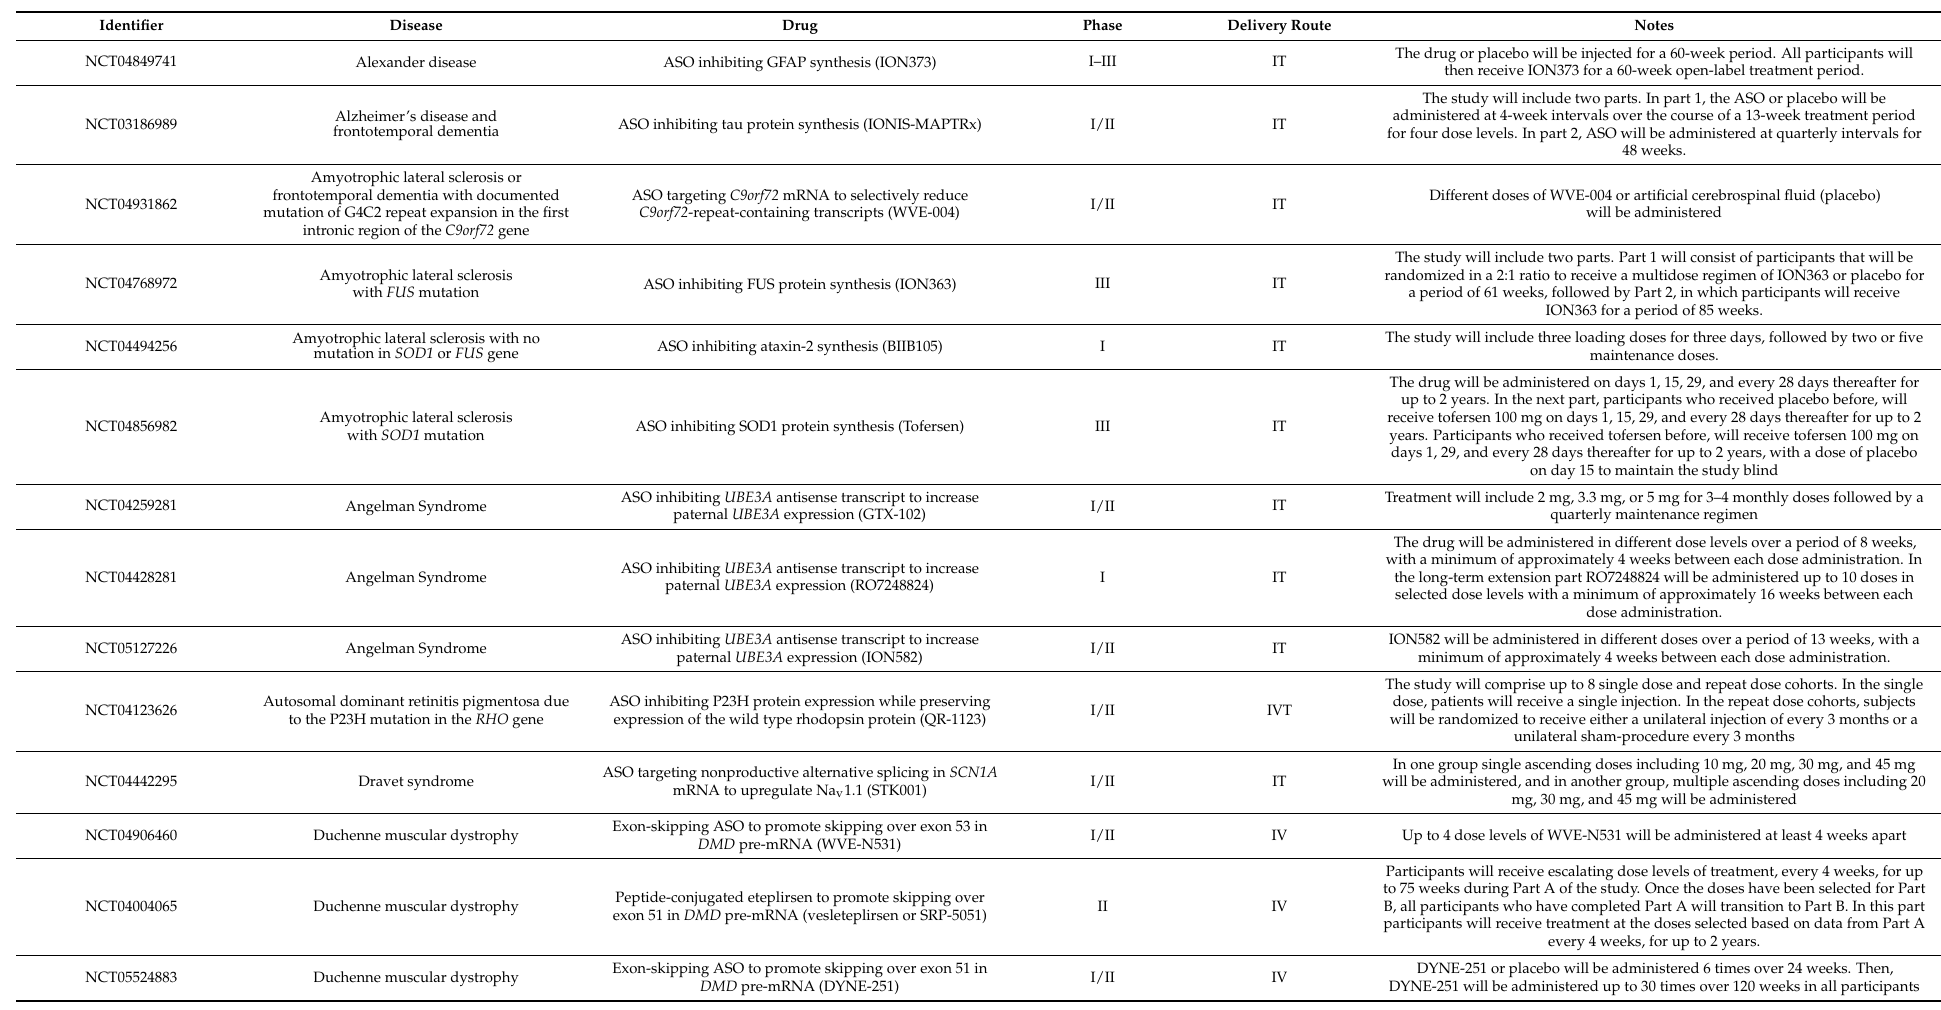
Table 3. Ongoing active clinical trials using antisense oligonucleotides in neurological disorders based on clinicaltrials.gov (accessed on 28 September 2022)